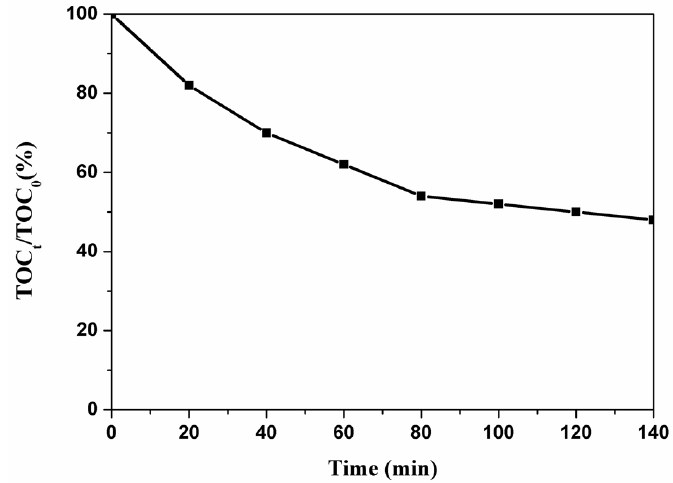
Figure 8. Total Organic Carbon (TOC) content of the degrading solution using the B-3D3 sample.